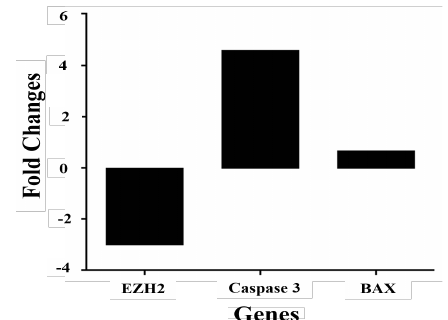
Fig. 1. Downregulation of Ezh2 expression shRNA- EZH2 mediate and increase caspase-3 (4.5 Fold) and little change in BAX mRNA (1.5 Fold) and levels cause inhibition EZH2 in the HCT116 cell line.